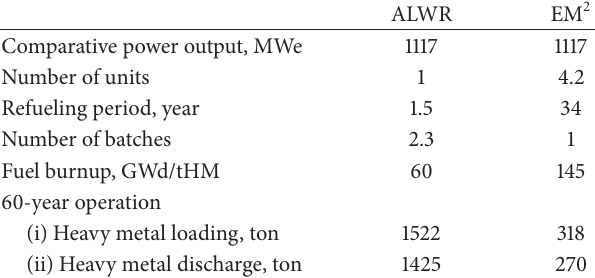
Figure 7: Fissile inventory change of EM 2 baseline core. Figure 9: Comparison of energy per natural uranium Table 3: Comparison of mass flow for once-through fuel cycle. ALWR